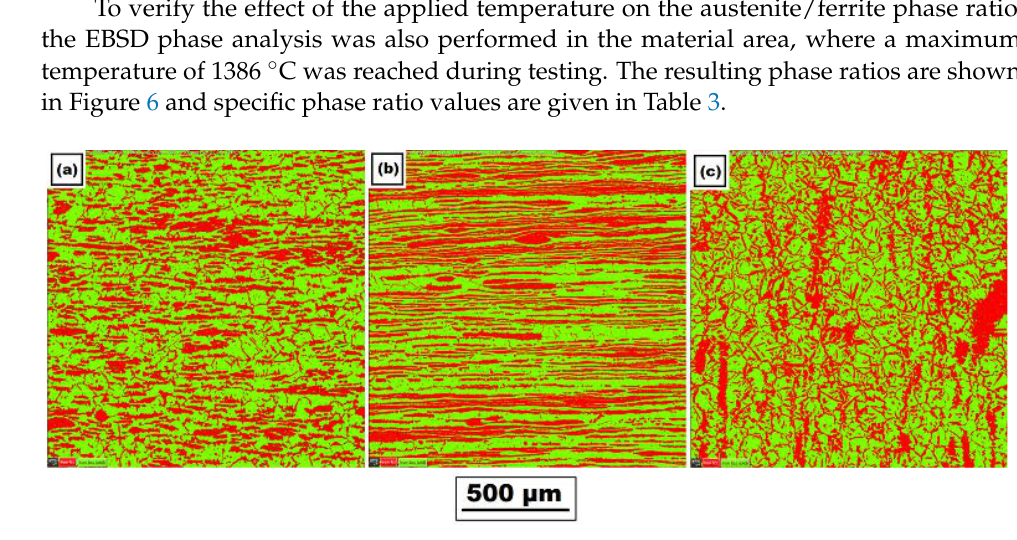
Figure 6. Distribution of ferrite (green) and austenite (red) in the area achieving the maximal tem- perature of 1386 °C along with the following directions: ( a ) X-axis (direction perpendicular to the rolling direction), ( b ) Y-axis (rolling direction), and ( c ) Z-axis (material thickness direction). Table 3. Percentage ratios of the individual phases along with the given directions: X, Y, and Z- axis.